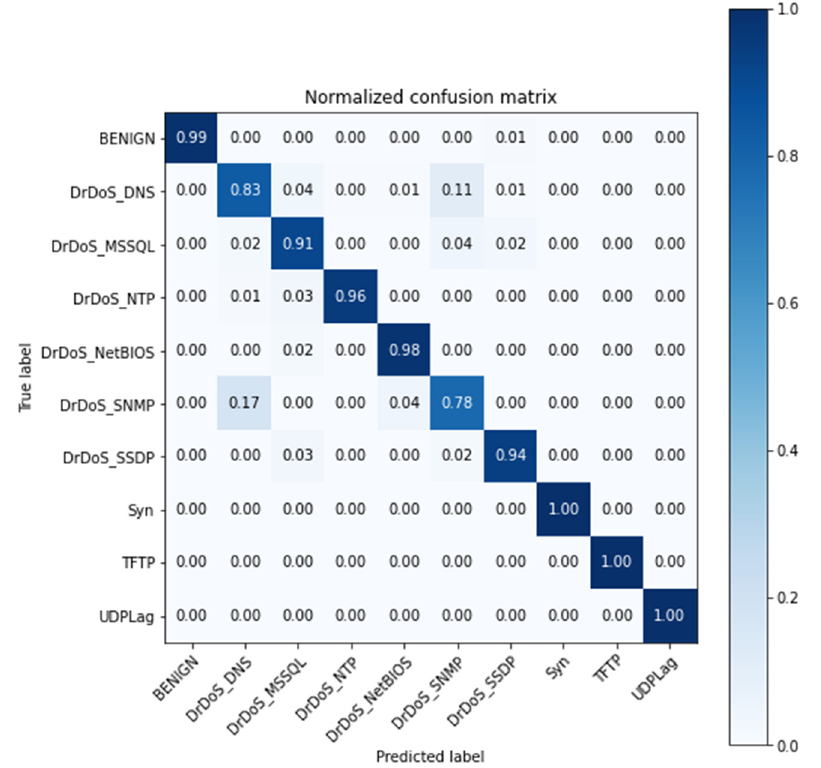
Figure 4. Confusion matrix for the second scenario.